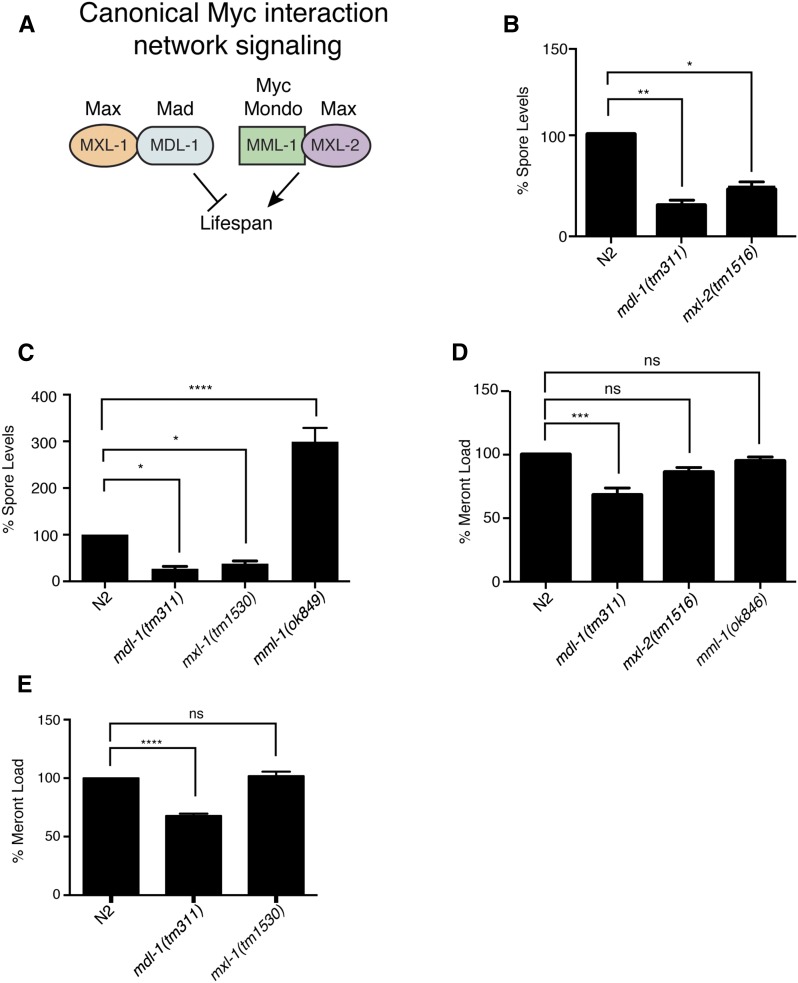
C.elegans Myc interaction network transcription factors regulate N. parisii pathogen development. (A) Canonical wiring of Myc interaction network transcription factors. The mammalian homologs are listed above the C. elegans genes. MML-1 and MXL-2 are thought to act as a heterodimeric pair that promotes transcription and lifespan, and their activity is opposed by MDL-1 and MXL-1 acting as heterodimeric pair. (B and C) Spore levels at 40 hpi shown as the mean of three independent experiments, normalized to wild type animals. (D and E) Pathogen load of N. parisii meronts at 24 hpi, measured using an N. parisii-specific rRNA FISH probe. Three technical replicates were performed in each of three independent experiments. Fluorescence was measured with a COPAS Biosort and normalized to time-of-flight as a measure of body size, and then normalized to wild-type animals, with at least 325 animals per technical replicate. ns, not significant. * P < 0.05, ** P < 0.01, *** P < 0.001, **** P < 0.0001.